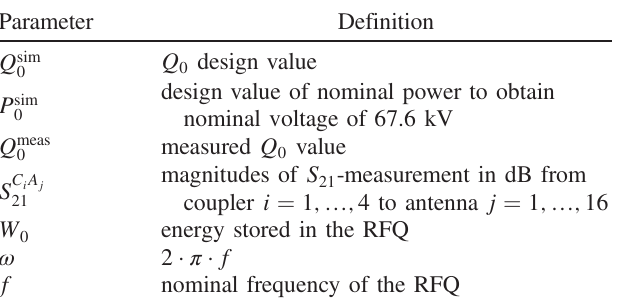
TABLE VI. Parameter definitions.